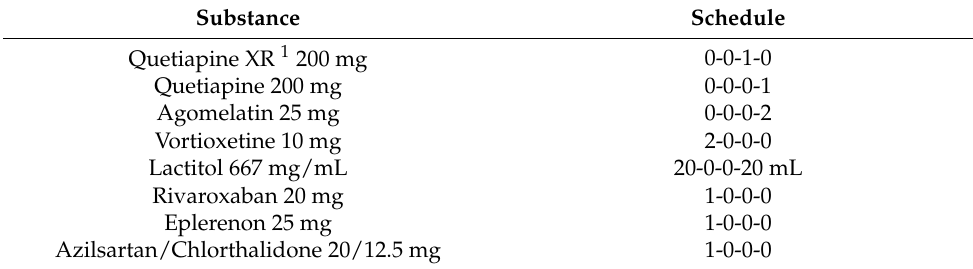
Table 1. Case #1 medication at the time of the reported severe